Question: Write a single sentence explaining what this figure depicts.
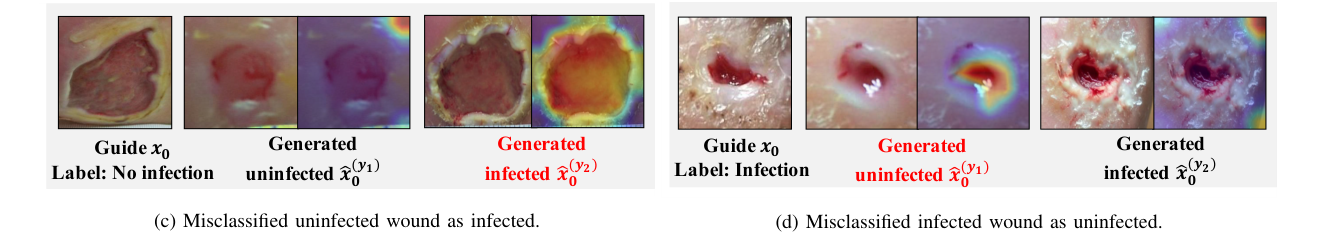
Answer: Visualization of ConDiff predictions with corresponding Score-CAM images computed from the ConDiff’s embedding model fφ. Each sub-figure shows an example with the guide image (x0), conditional synthesized images representing uninfected ˆx(y1) 0 and infected ˆx(y2) 0 states, and their respective Score-CAM overlays indicate regions with similar features to x0.